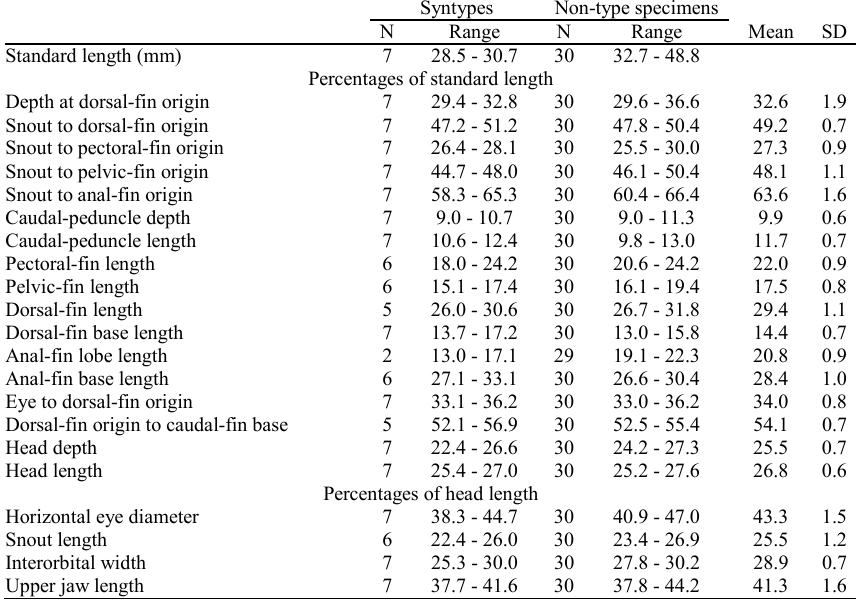
Table 1. Morphometric data of Astyanax multidens . SD for Standard Deviation.